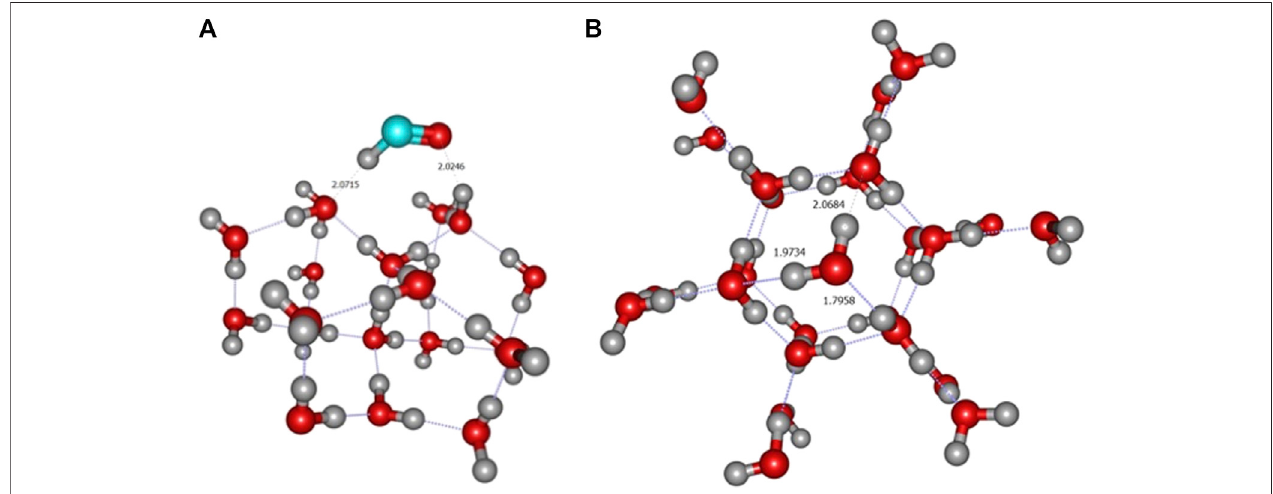
FIGURE 6 | ONIOM( ω B97X-D/6-31+G**:PM6) most stable geometry for HCO (B3 site) (A) and H 2 O (A2 site) (B) molecules on crystalline ice.